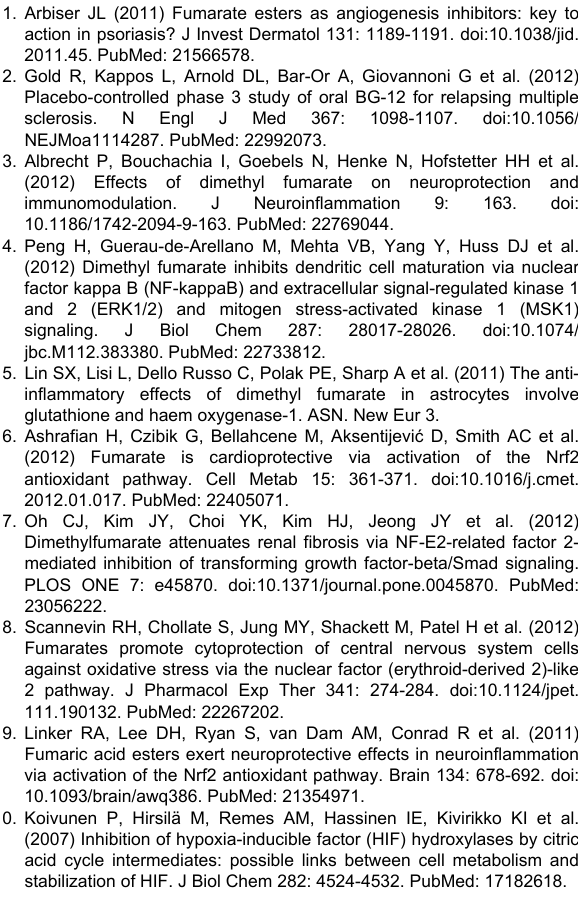
Figure S2. FAEs induce Nrf2 in transgenic ALS astrocytes. Transgenic (mSOD1-G93A) astrocytes were treated with 30µM DEF (A, C) or 30µM DMF (B, D) for the indicated times. Nrf2 levels were measured in duplicates by western blot. *, p<0.05, **, p<0.01 significantly different from corresponding control (ANOVA followed by post-hoc Newman-Keuls). Values are the means +/- SEM of n=2 independent experiments.